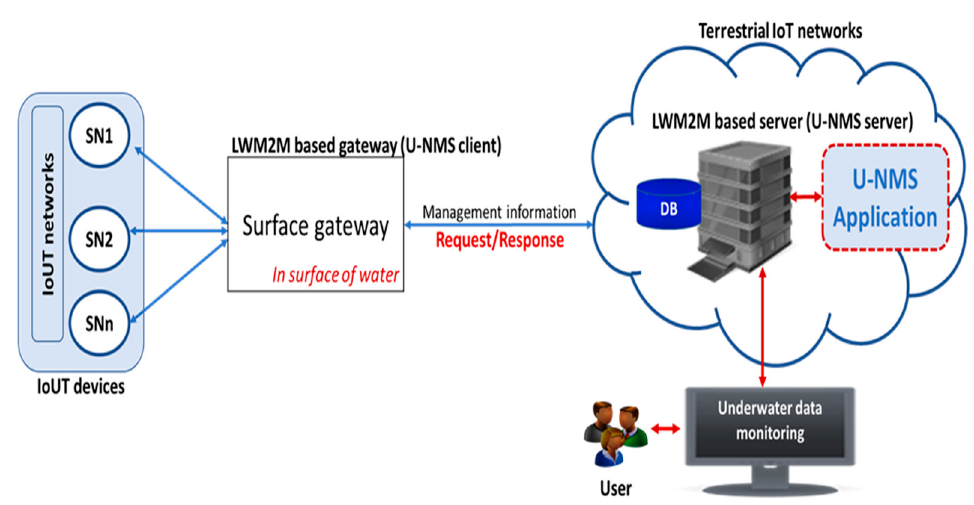
Figure 11. Conceptual architecture of LWM2M based U-NMS. Table 6. Requirements of proposed U-NMS.